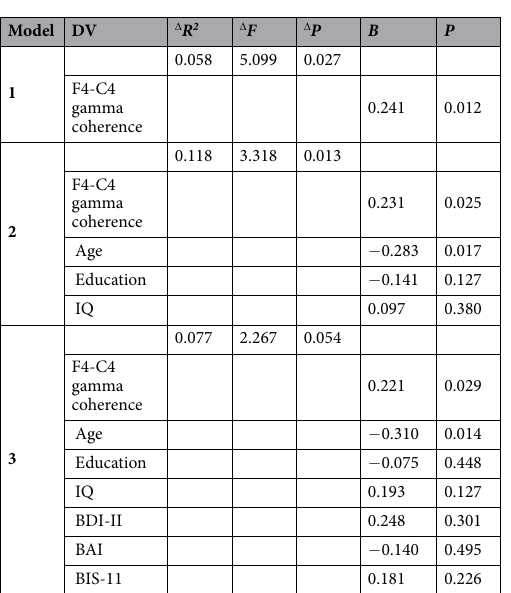
Table 3. Hierarchical regressions predicting the score on IAT in the IGD, AUD, and HC groups. Hierarchical regression models predicting the score on IAT were conducted for all participants in this study. Fisher’s Z-transformed scores were used for the EEG data. 2000 sample bootstrapping was applied with regression analyses, and the significance level was set at 0.050. IAT = Young’s Internet Addiction Test; IGD = Internet gaming disorder; AUD = alcohol use disorder; HC = healthy control; F3-C3 = left hemispheric frontocontral, IQ = intelligence quotient; BDI-II = Beck Depression Inventory-II; BAI = Beck Anxiety Inventory; and BIS- 11 = Barratt Impulsivity Scale-11; EEG =